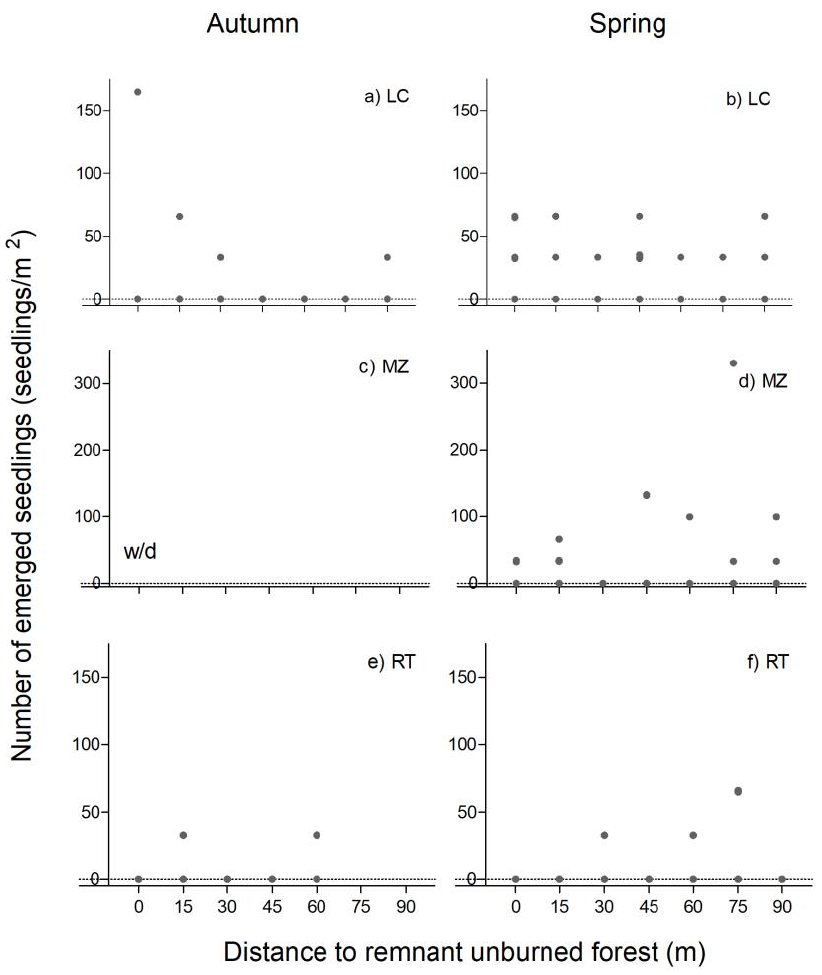
Figure 4. Emergence of dwarf shrub-shrub species in La Colisión (LC, ( a , b )), Monte Zeballos (MZ, ( c , d )) and Río Turbio (RT, ( e , f )), as a function of the distance from the edge of the remnant forest to the area burned in autumn (left) and spring (right). Dot represents the observed emergence in each sample soil. w/d: without data.